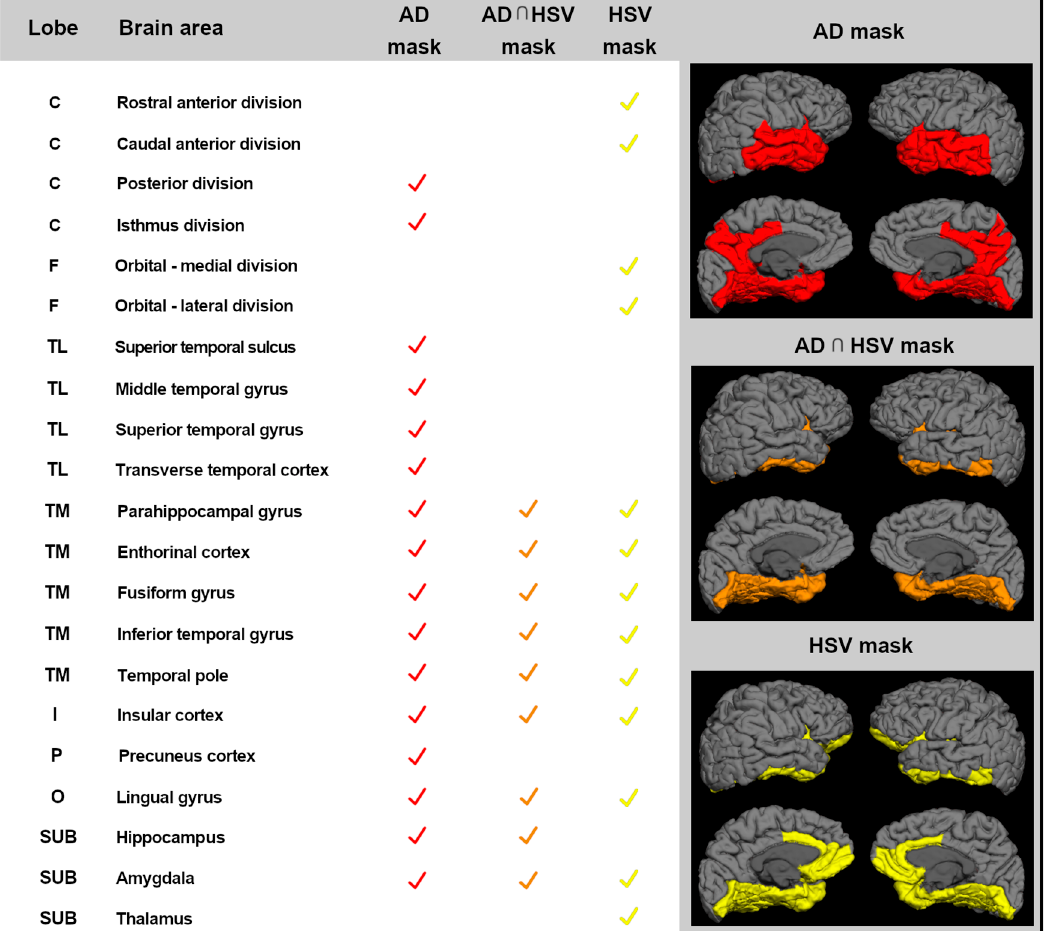
Figure 1. Ad-hoc masks of brain areas considered in the statistical analyses. List of all the brain areas included in each mask: in red color, brain regions that are target areas in the mild stages of AD pathology (AD mask); in yellow color, cortical areas that are the target for HSV-1 encephalitis (HSV-mask); and in orange color, the areas commonly shared by AD mask and HSV-mask (AD ∩ HSV-1-mask). AD: Alzheimer disease; C: cingulum; F: frontal; TL: temporal lobe, lateral aspect; TM: temporal lobe, medial aspect; I: insula; P: parietal; O: occipital; SUB: subcortical volumes.